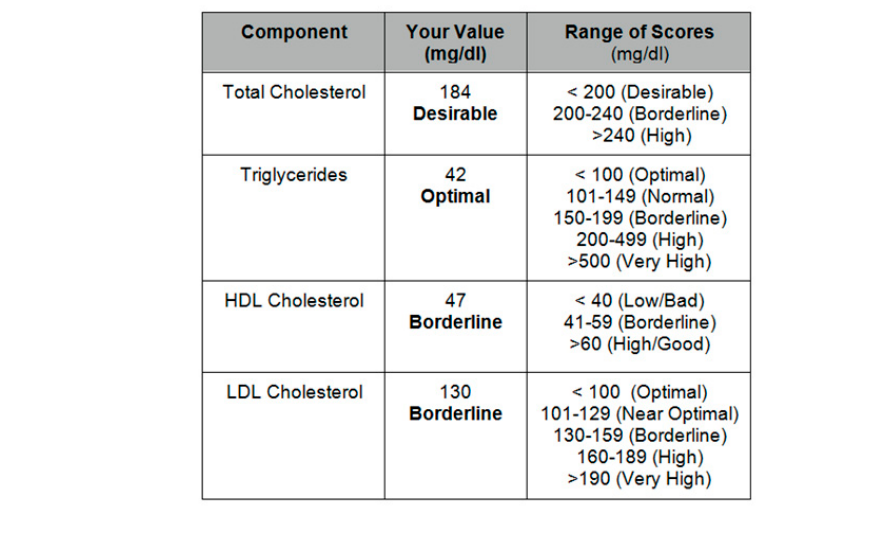
Figure 1. Verbally Enhanced Cholesterol Message (Morrow et al. 2017; Morrow et al. 2019).